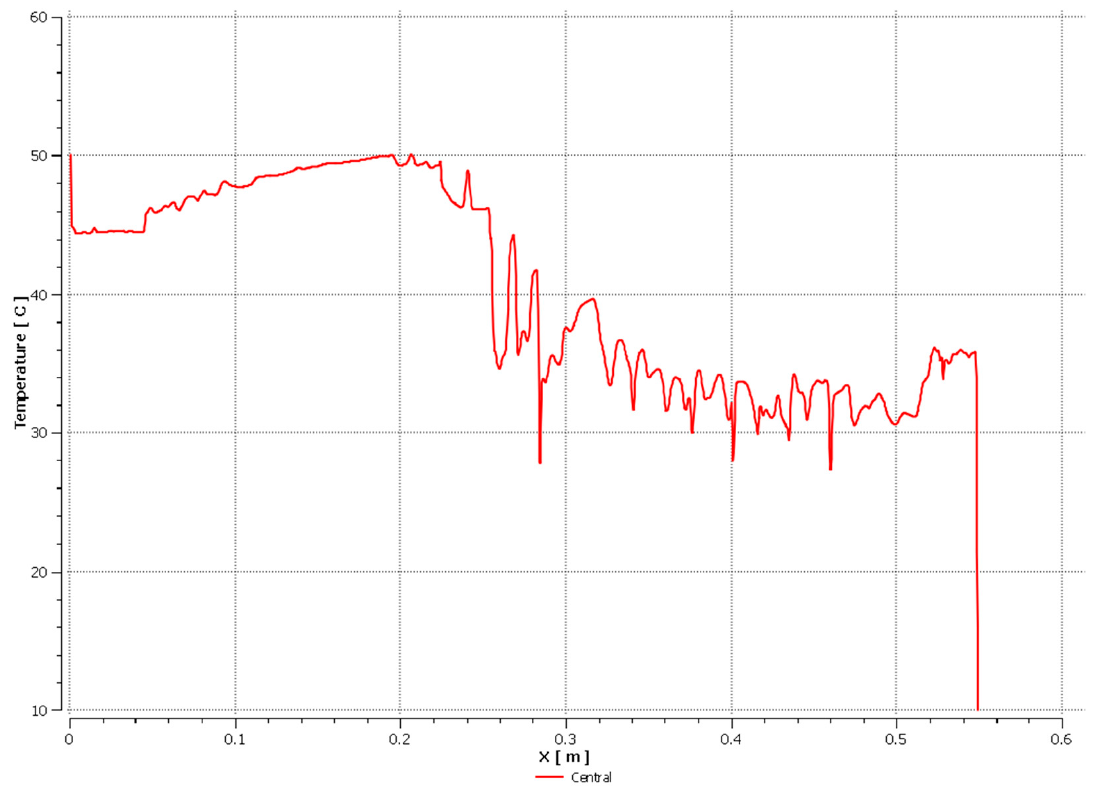
Figure 24. Temperature distribution along the height of the heat pipe’s central line.